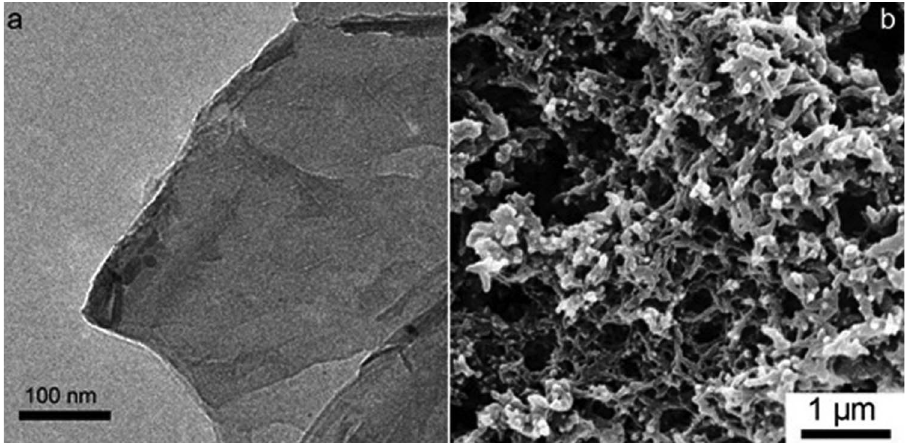
Figure 1: The morphology and uniformity of the amended electrodes: ( a ) TEM and ( b ) FESEM images of the MeGO and pellet/ fl ake - like MeGO/PANI, respectively.